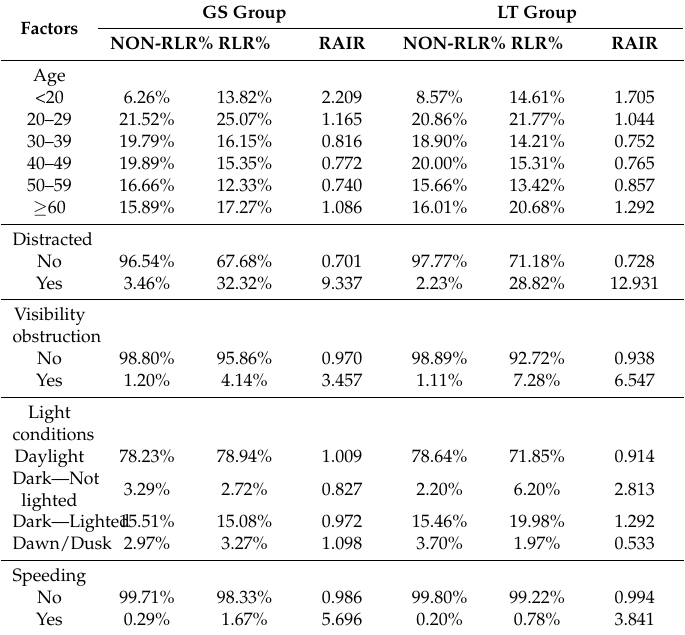
Table 2. Relative crash involvement ratio (RAIR) comparisons between GS group and LT group.